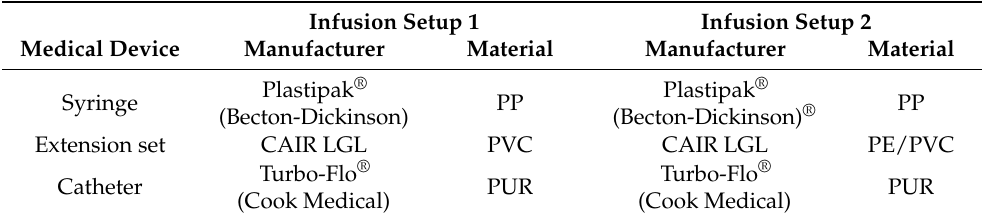
Table 2. Composition of the two studied complete infusion setups (PP: polypropylene; PVC; polyvinyl chloride; PE; polyethylene; PUR: polyurethane).